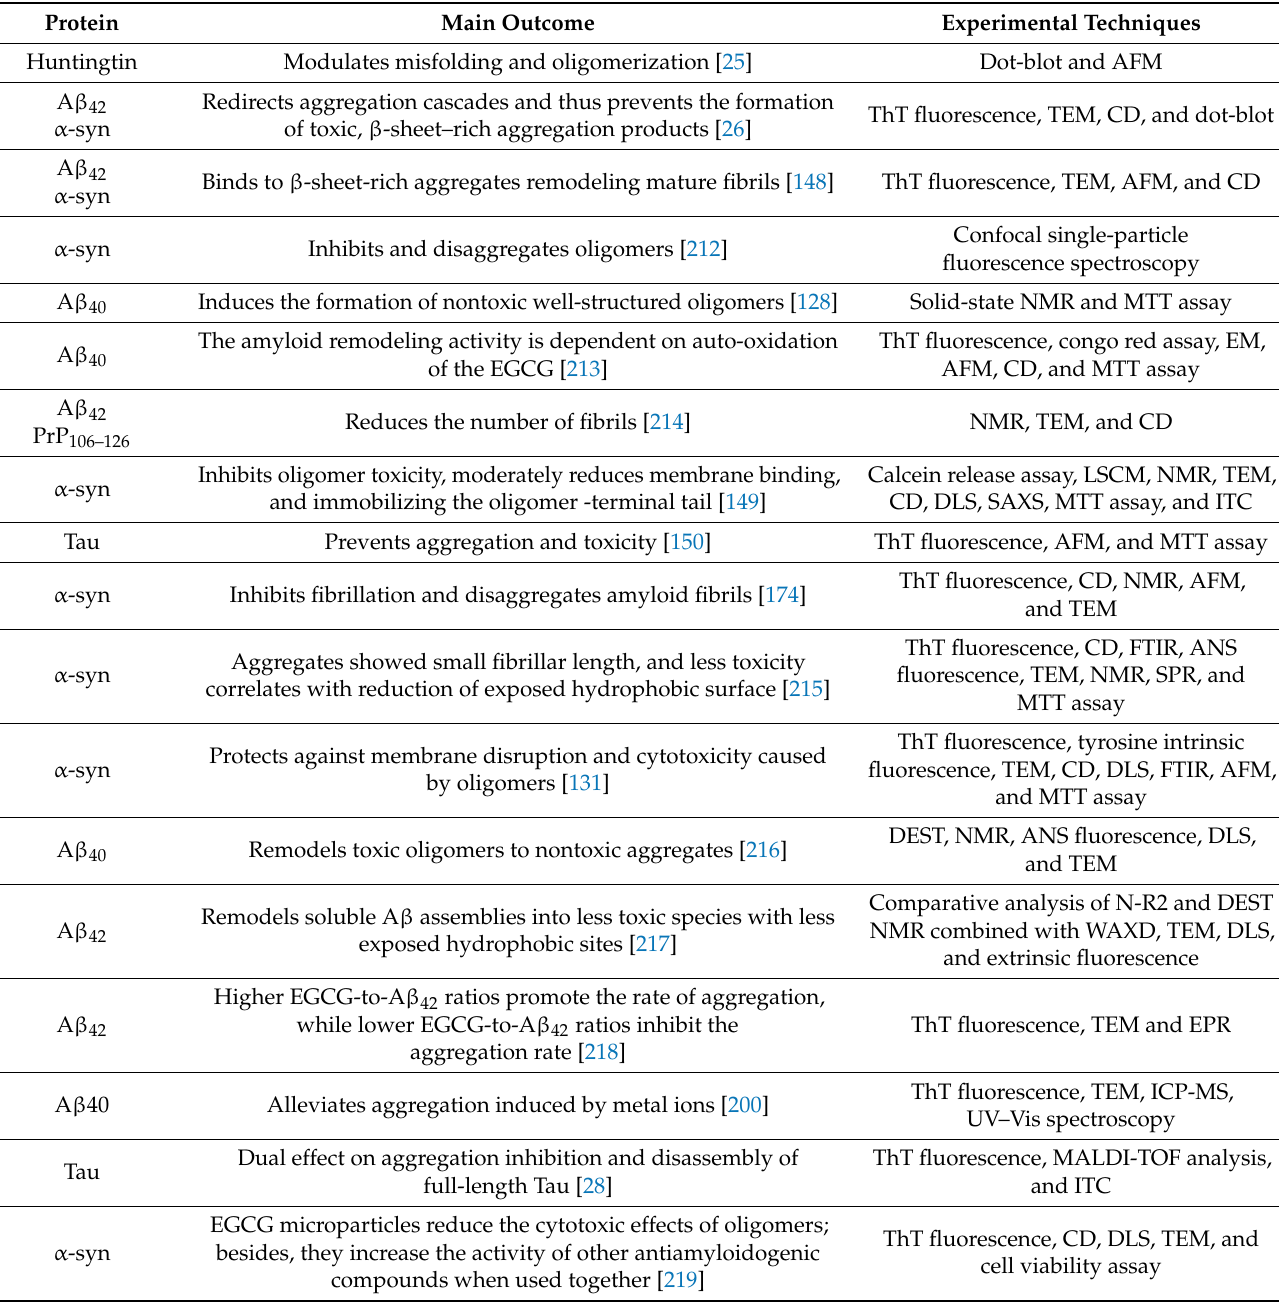
Table 4. Main evidence that EGCG targets toxic misfolded aggregates in neurodegenerative diseases. Protein Main Outcome Experimental Techniques Huntingtin Modulates misfolding and oligomerization [25] Dot-blot and AFM A β 42 α -syn